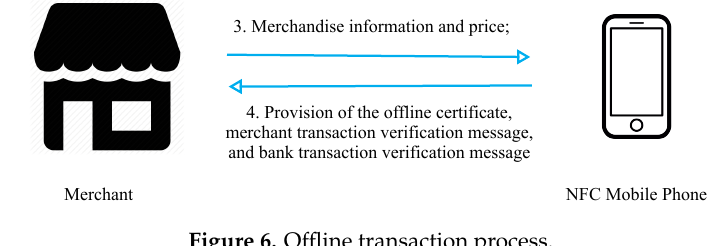
Figure 6. Offline transaction